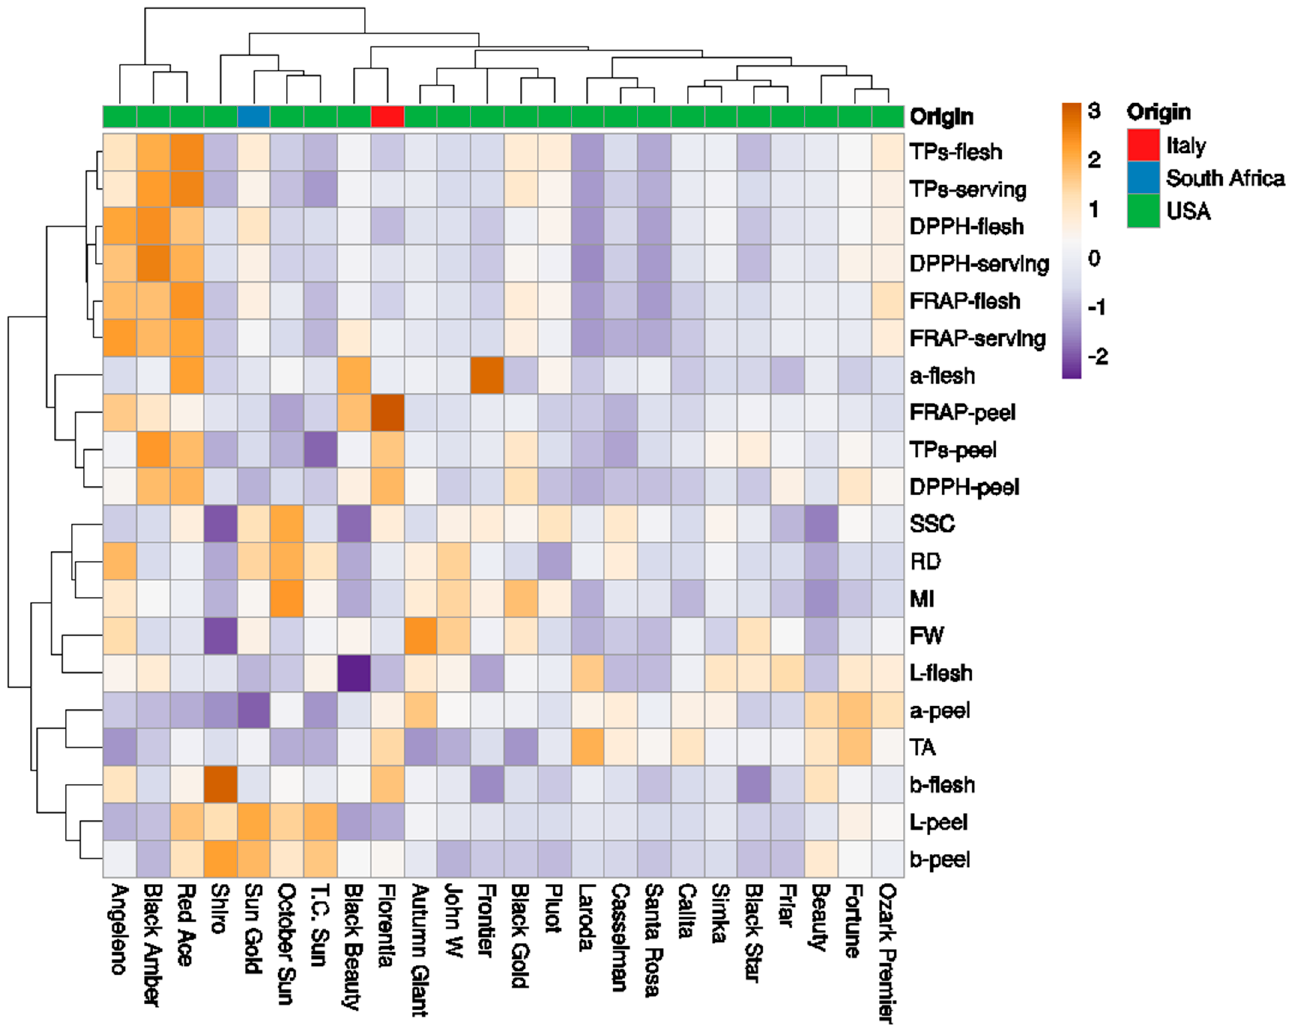
Figure 6. Heatmap showing the clustering of fruit phenotyping traits in 24 Japanese plum cultivars using the ClustVis software. The columns correspond to the cultivars and the rows correspond to the fruit phenotypic traits studied. Both rows and columns were clustered using Euclidean distance and the Ward method.